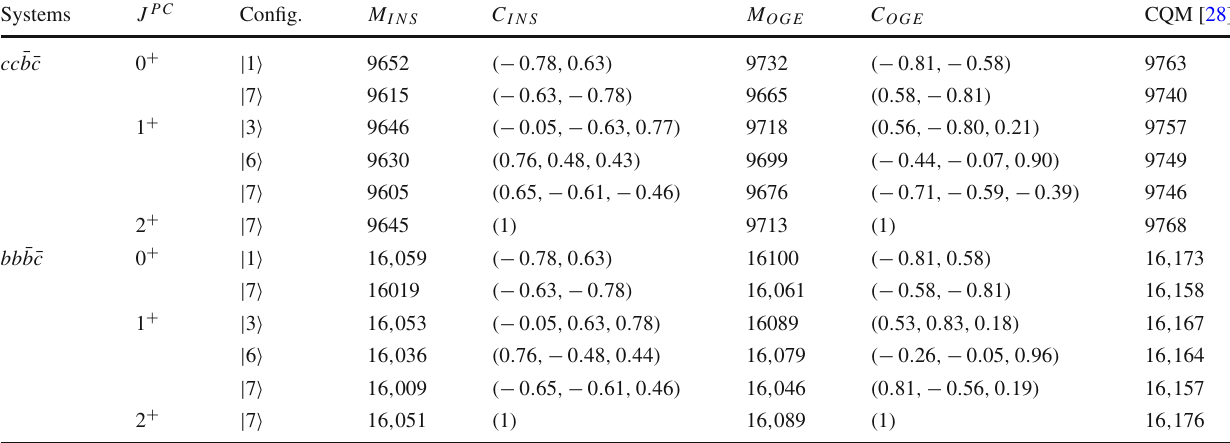
Table 6 The numerical results of spectrum for the S -wave cc ¯ b ¯ c and bb ¯ b ¯ c states compared to the predictions in Ref. [28], conventions same as in Table 4